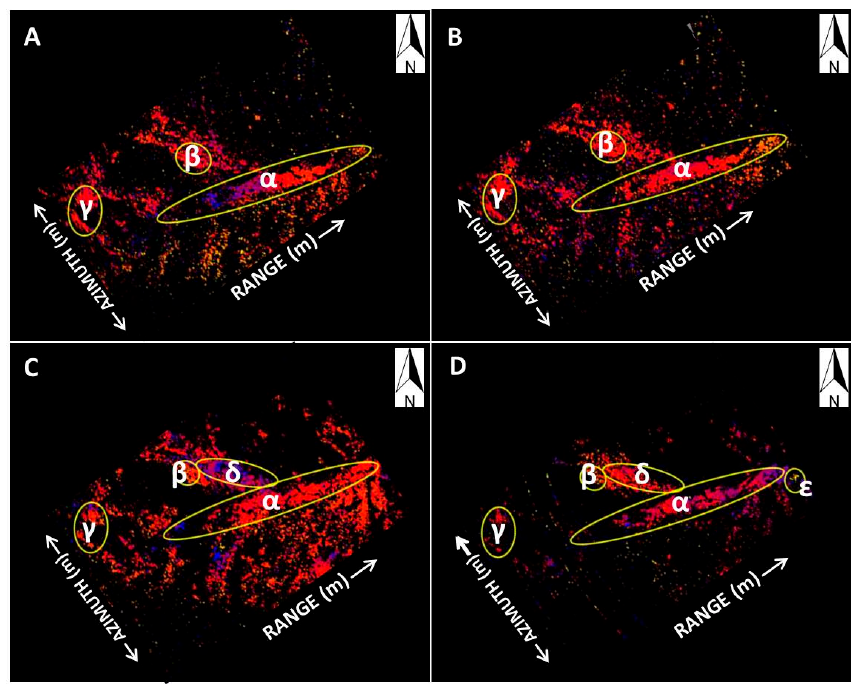
Remote Sens. 2017 , 9 , 165 15 of 4 Displacements were also registered in sectors δ and ε , respectively, affected by the cumulated values of about 100 and 150 mm (Figures 10, 11 and 12D–E). Figure 9. Interferograms acquired in “slow mode” and referred to a period of 24 hours. ( A ): 15–16 July 2013, sector α = 2 mm/day, sectors β and γ = less than 1 mm/day; ( B ): 16–17 July 2013, sector α = 1 mm/day, sectors β and γ = less than 1 mm/day; ( C ): 19–20 January 2014, sector α = 1 mm/day, sectors β and γ = less than 1 mm/day, sector δ = 2 mm/day; and ( D ): 18–19 February 2014,– sector α = 1 mm/day, sectors β , γ , and δ = less than 1 mm/day, sector ε = 5 mm/day.